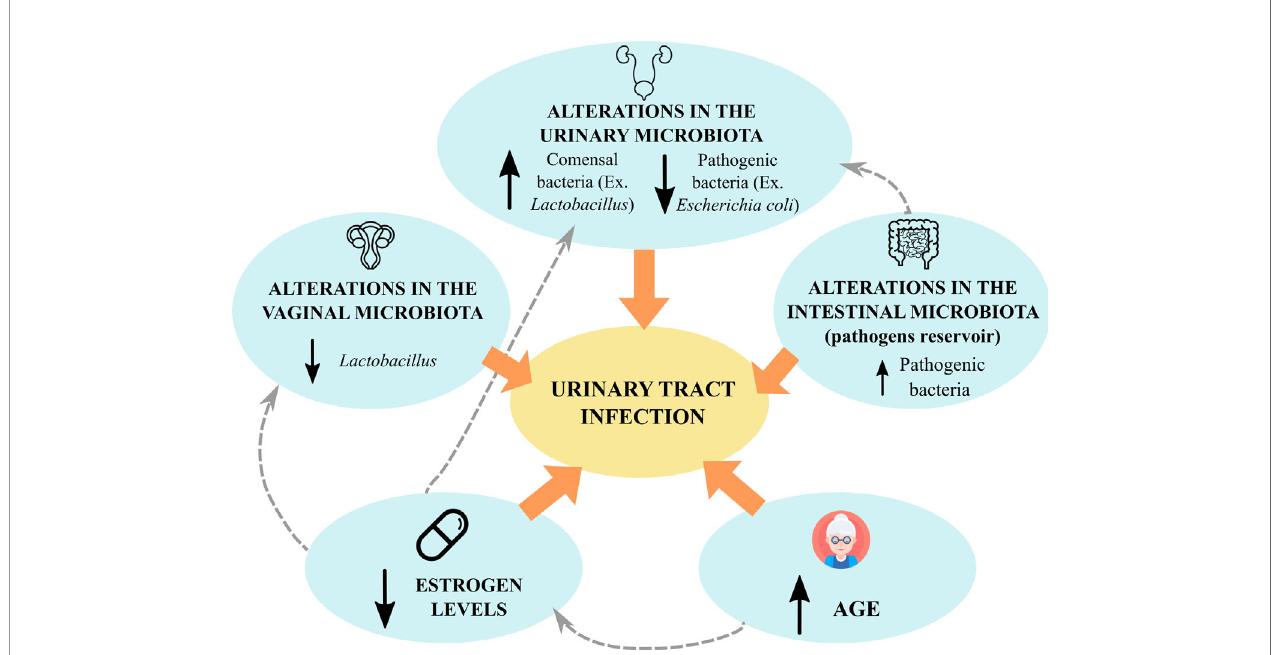
FIGURE 4 | Risks factors for urinary tract infections related to the microbiota. UTIs may be in fl uenced by different risk factors related to microbial communities: alterations in the urinary microbiota (either an increase in uropathogens or a decrease in commensal bacteria) (Thomas-White et al., 2018a), alterations in the intestinal microbiota (increase in uropathogens in the intestinal reservoir) (Magruder et al., 2019) and increasing age, which is related to a decrease in estrogen levels in women and fl uctuations in abundance of Lactobacillus (Thomas-White et al.,